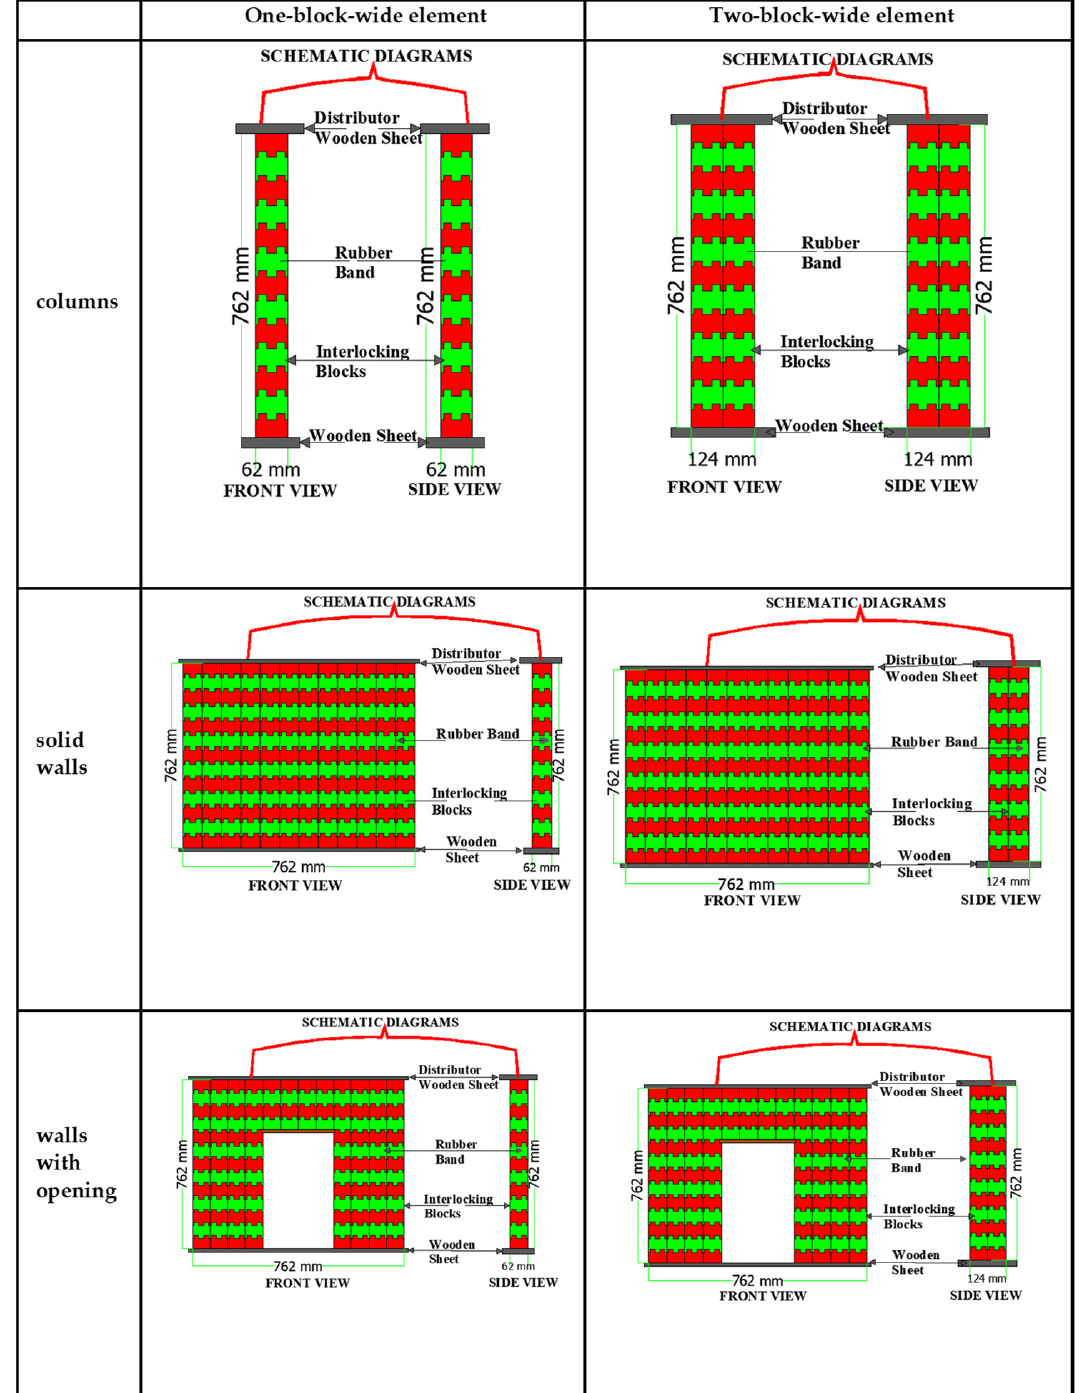
Figure 4. Schematic diagrams of interlocking-plastic-block structural